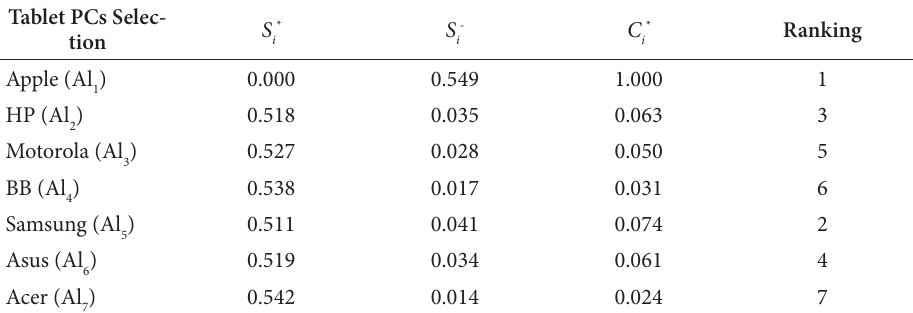
Table 5. Final evaluation of the alternatives in